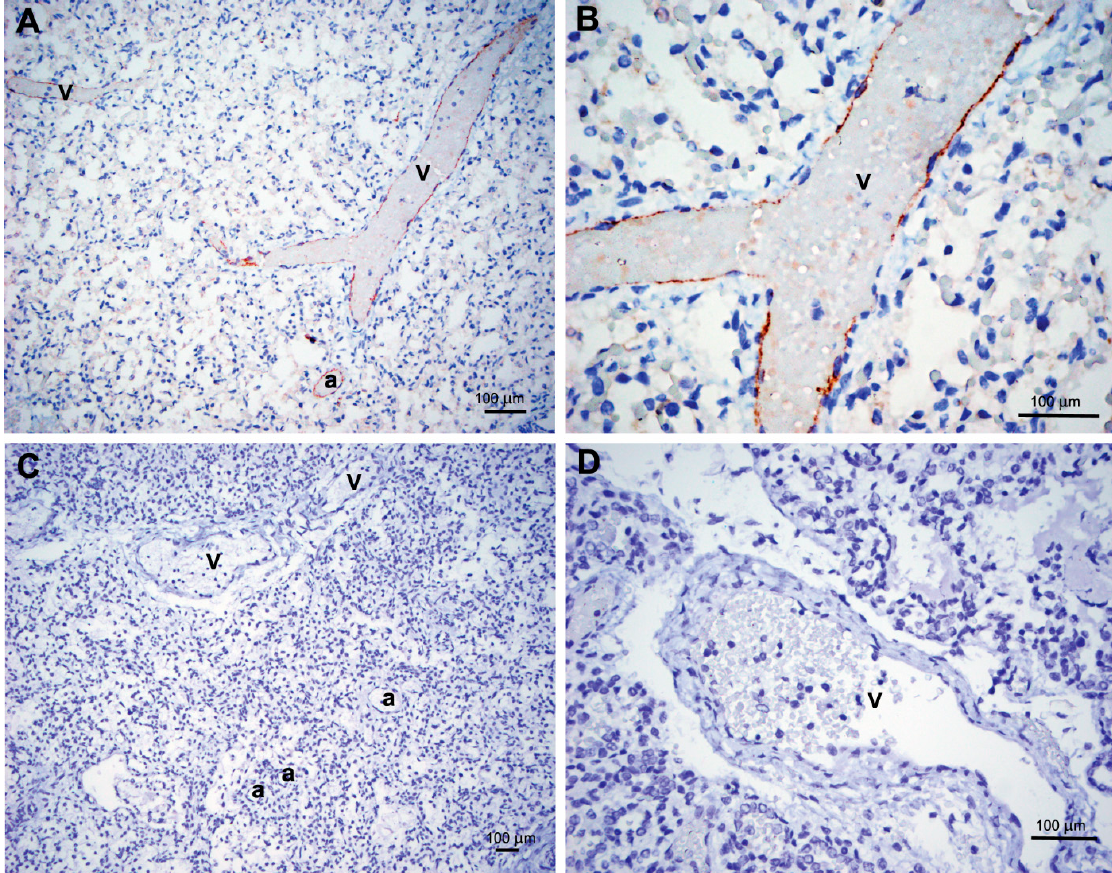
Figure 4. Immunohistochemistry with antibody against SARS-CoV-2 nucleocapsid protein in lungs of 3 stillborn fetuses of mothers with positive COVID-19 serology testing. ( A , B ) Positive punctate and granular staining of the endothelium of distended veins (v) and small arteries (a) in a 38-week fetus. ( C ) Negative staining results in a 26-week fetus. ( D ) Negative staining results in a 30-week fetus.